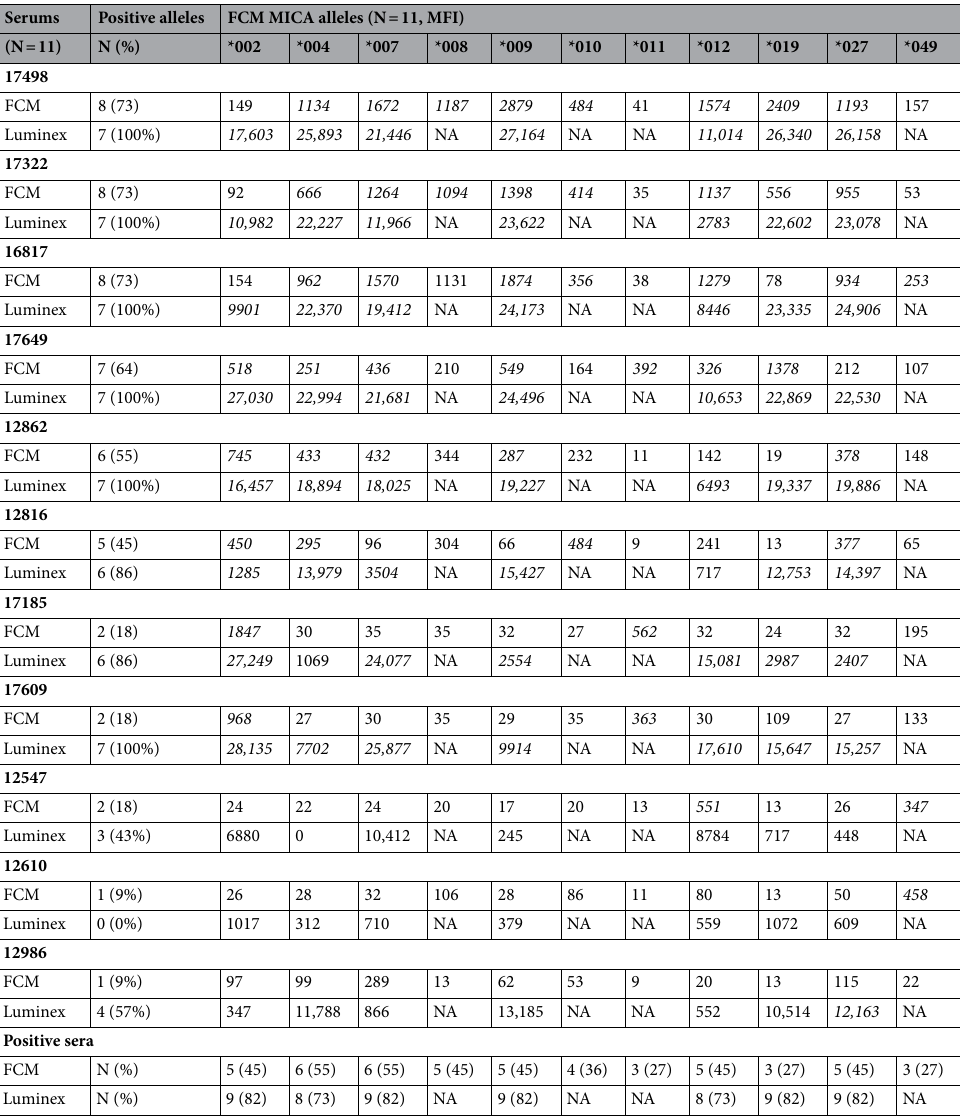
Table 2. Specificities to single MICA alleles of 11 positive sera. *Values marked in italics indicate a positive reaction as more than the cut-off value. NA not